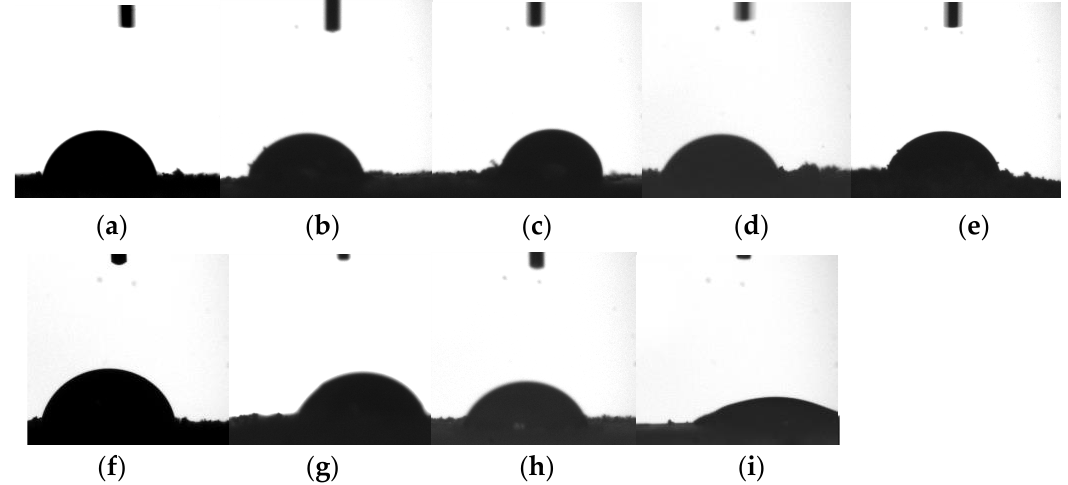
Figure 2. Image of the drop shape for the wet biomasses obtained through brewing yeast biotechnological processing for the experiments within the fractional experiment matrix 3 4 (Table 2): ( a ) exp. 1; ( b ) exp. 2; ( c ) exp. 3; ( d ) exp. 4 ( e ) exp. 5; ( f ) exp. 6; ( g ) exp. 7; ( h ) exp. 8; and ( i ) exp. 9.